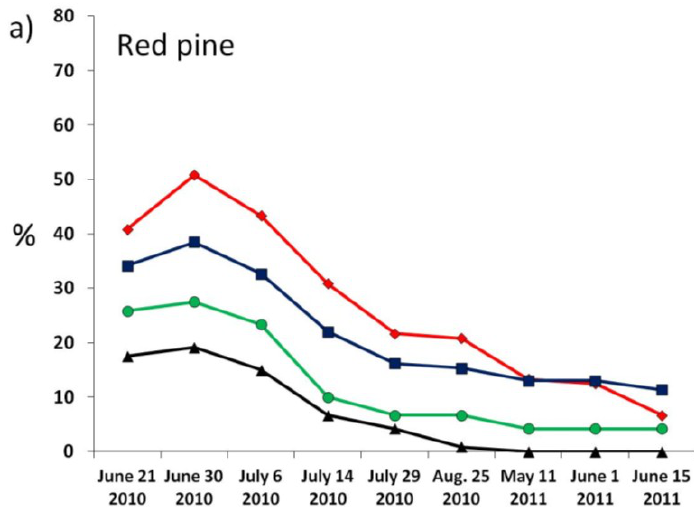
Figure 1. Mean percentage of live seedlings in response to treatments “vegetation” and “protection”, between 21 June, 2010 and 15 June, 2011 for ( a ) red pine; ( b ) sugar maple; and ( c ) red oak. Sub-figures ( a to c ) ordered by species seed